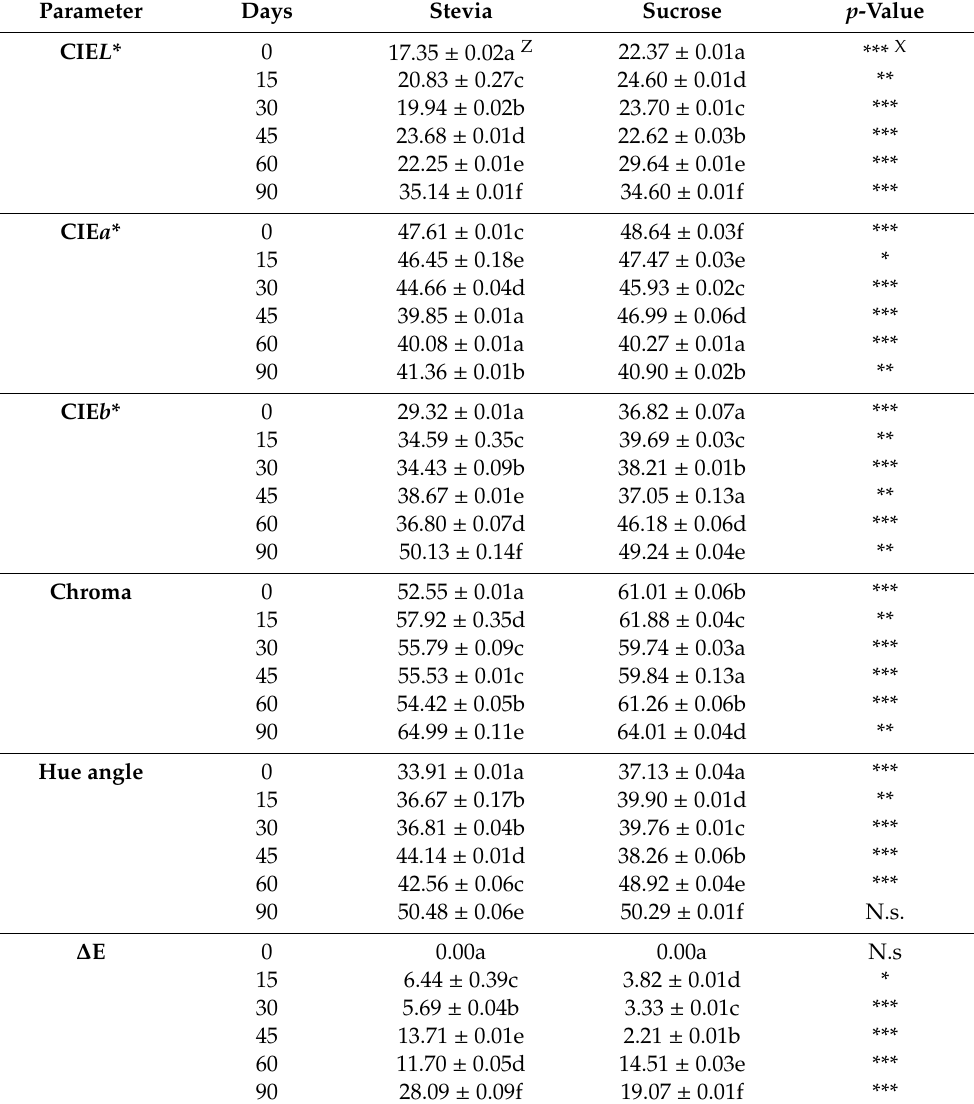
Table 5. CIE L * a * b * values in beverages stored at 25 ◦ C under dark